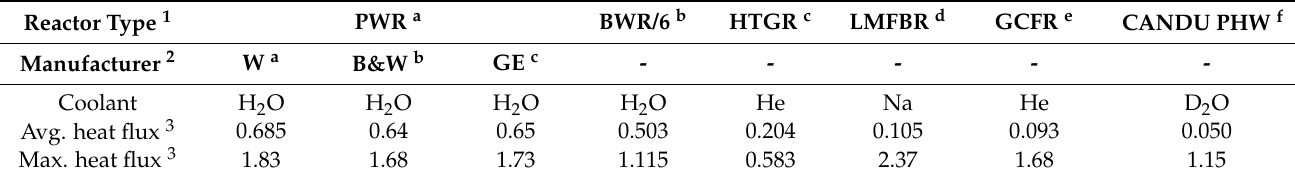
Table 6. Experimental VLSI heat sink with water filled microchannels [23].